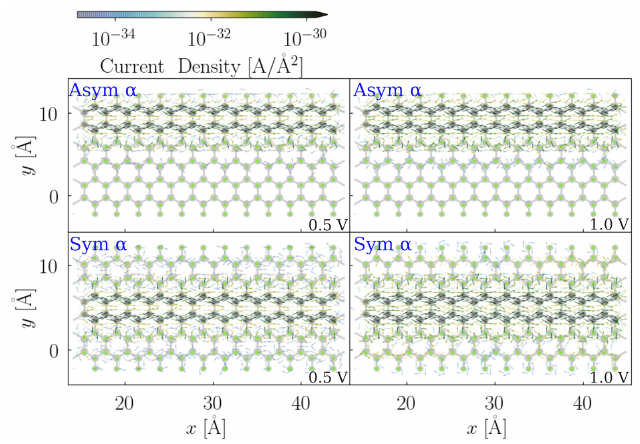
Figure 11. Quiver plot of the electronic current density projected on the real space of the scattering regions of both asymmetric and symmetric 66.67% fluorinated F-6Z. The grid spacing is chosen as 1 atomic unit in the volume of the cell cartesian coordinates. The bias voltage along the x -axis of the nanojunction plane is applied. The upper panels illustrate the α spin channel of asymmetric 66.67% fluorinated F-6Z (originated from 4(A)) both at 0.5 V and 1 V bias voltage, respectively. The lower panels denote the α spin channels of symmetric 66.67% fluorinated F-6Z (originated from 4(B)) at 0.5 V and 1 V bias